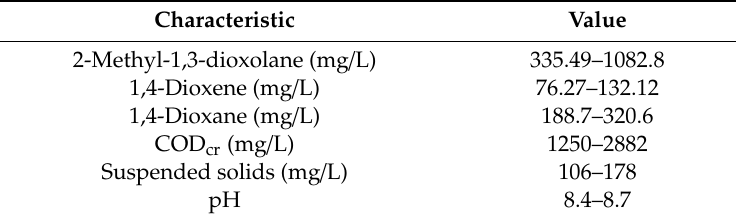
Figure 1. Biodegradation of 1,4-dioxane with varying concentrations of biomass and model predictions. COD: chemical oxygen demand; HRT: hydraulic retention time. Table 1. The characteristics of the textile wastewater.